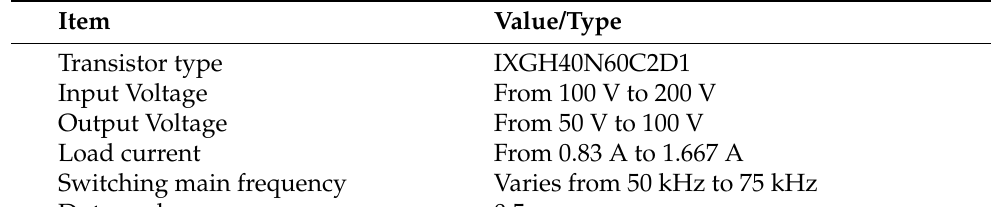
Table 2. DC/DC converter electrical data.